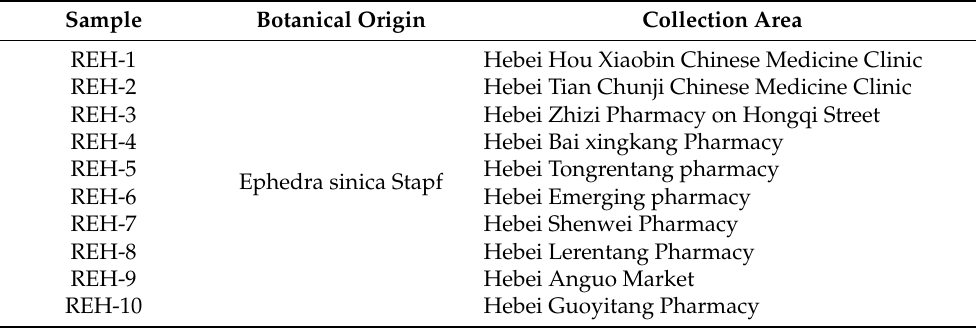
Table 4. Information of Raw Ephedrae Herba (REH) samples used in this study. Sample Botanical Origin Collection Area